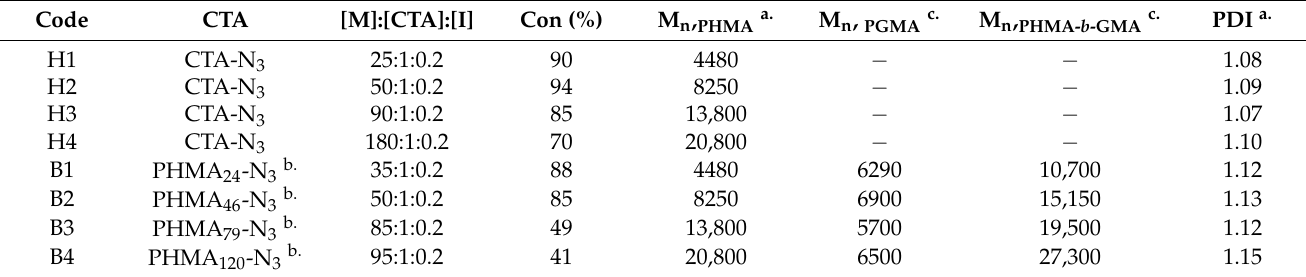
Table 4. RAFT polymerization of HMA and GMA in dioxane.